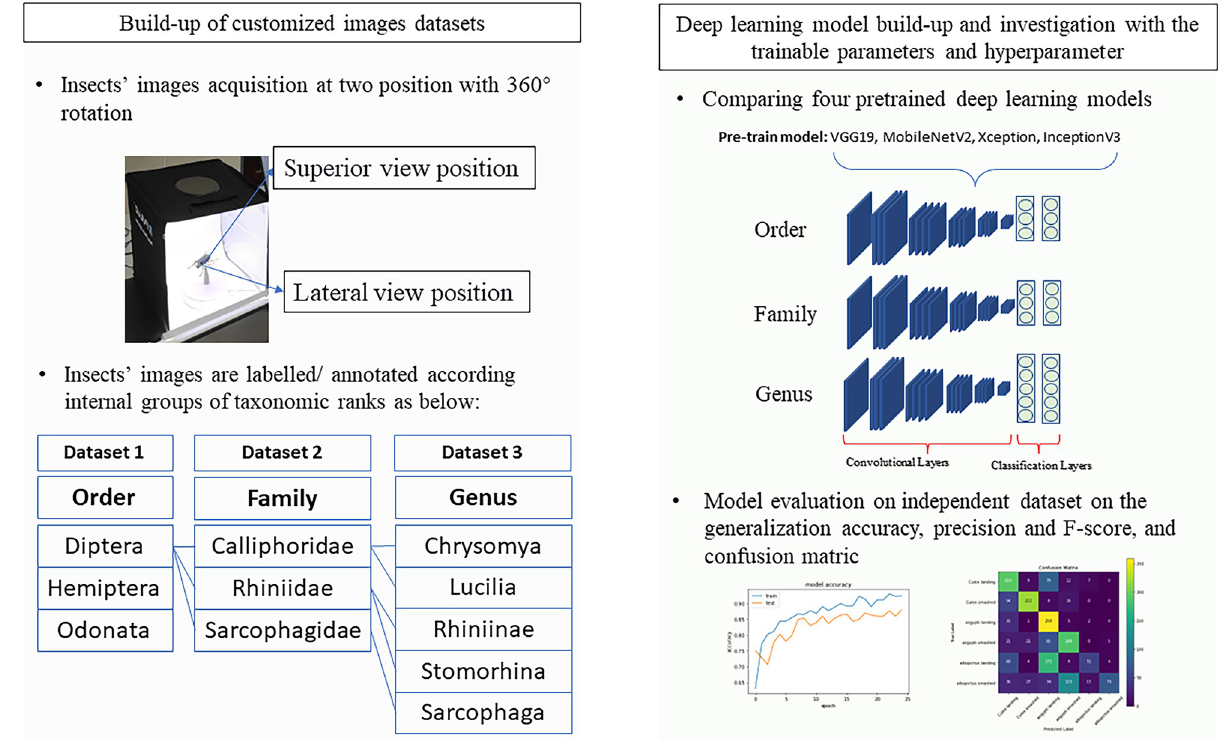
Fig 1. Overall workflow: Stage one consists of building up three customized datasets, and stage two involves the comparison and investigation of four state-of-the-art deep learning models.